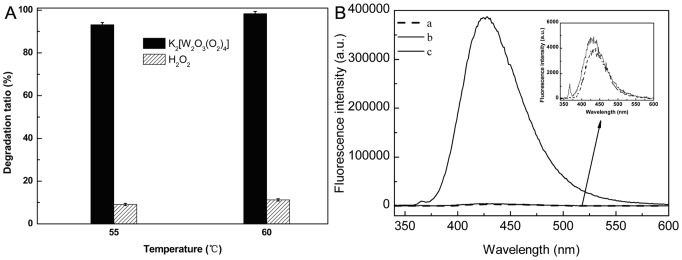
The comparison of different peroxo species, the peroxo species K2 [W2O3(O2)4] (2.5 mmol) and H2O2 (10 mmol), respectively, under the same reaction conditions: 5 mL H2O, 20 min (A), and the Fluorescence spectra changes (excitation at 315nm) with different addtives (B), a. terephthalic acid (5 ×10−5 M), Na2WO4 (4.2 µmol), H2O2 solution (100 µL) b. terephthalic acid (5 ×10−5 M) and H2O2 solution (100 µL). c. terephthalic acid (5 ×10−5 M), K2[W2O3(O2)4] (2.1 µmol), H2O2 solution (100 µL), under the same reaction conditions: 55°C, 2 min.